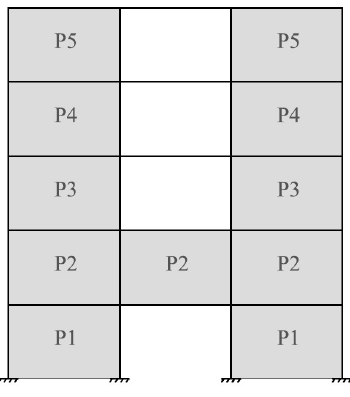
54.52 The optimum weight of SPSW3-5 was 24.86% lower than that of SPSW3-5-SGA (162.12 kN). As shown in Figure 10, SGA converges prematurely and falls into a local optimal solution; while IGA can obtain a better solution than SGA by finding an efficient cross direction through DBHX, obtaining new individuals through a substitution opera- tion, controlling the mutation scale by the adaptive mutation operator, and retaining the best individuals of each generation by the elite scheme.